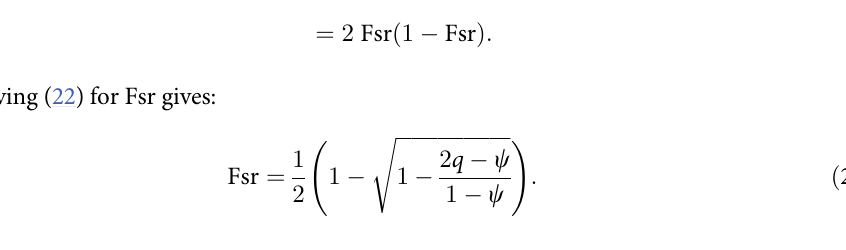
p� � ffiffiffiffiffiffiffiffiffiffiffiffiffiffi 1 (cid:0) 2 b q